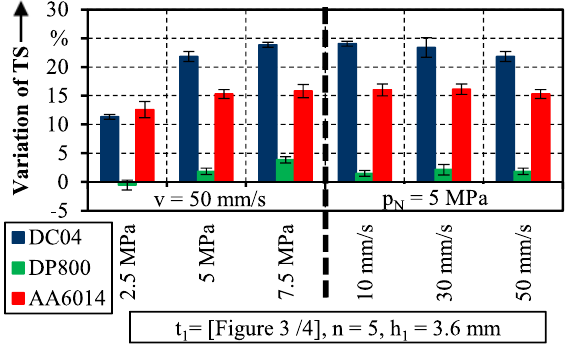
Fig. 9. Modi fi cation of the tensile strength TS in tensile tests after preloading in a drawbead passage with h 1